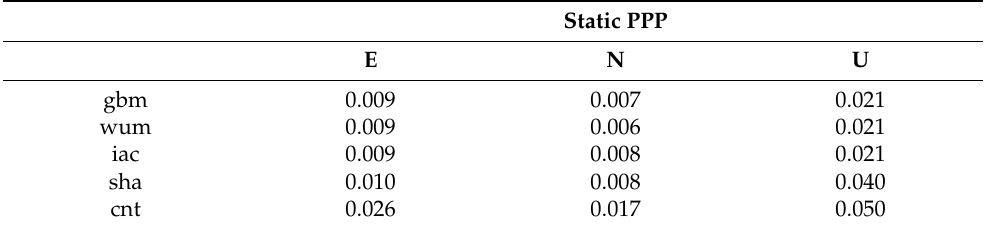
Figure 6. Boxplot of the positioning accuracy in East, north, and up (ENU) directions derived from BDS-3 PPP in static mode with different precise products. Table 5. The median of positioning accuracy in ENU directions derived from BDS-3 PPP in static mode with different precise products (unit: m).